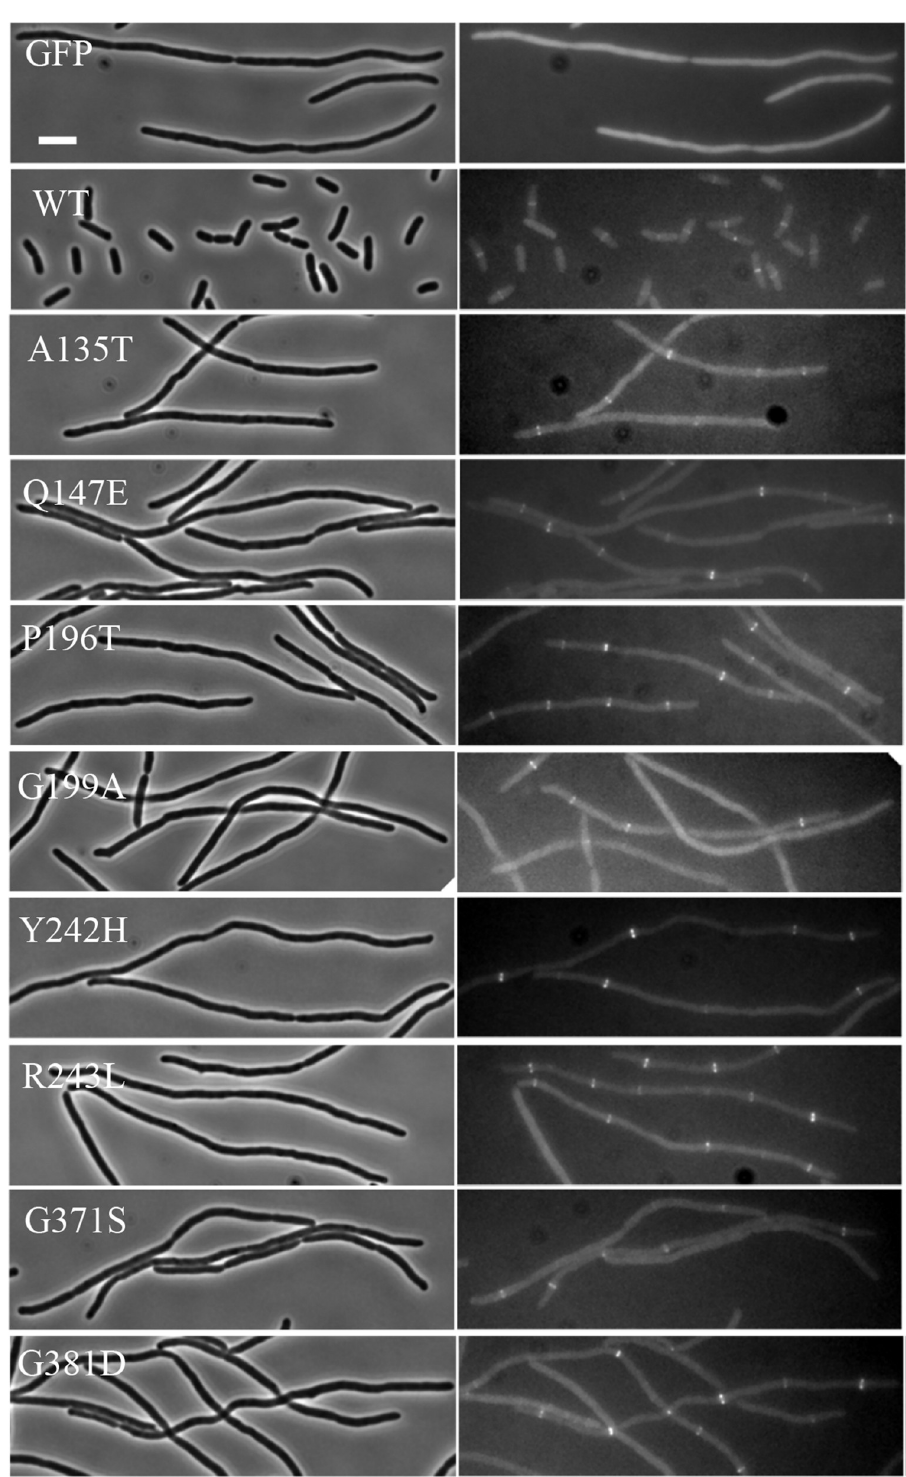
Fig 5. Dominant-negative FtsW mutants localize to the Z ring. Localization of the FtsW mutants was assessed in the FtsW depletion strain SD237 [W3110, leu ::Tn 10 ftsW :: kan/ pDSW406 (P BAD :: ftsW ) ] using plasmid pSD349 (P 206 :: ftsW- l60-gfp ) and derivatives carrying ftsW mutations. Overnight cultures of SD237 carrying derivatives of plasmid pSD349 were diluted 1:100 in fresh LB medium with antibiotics and arabinose. 2 hrs later arabinose was removed